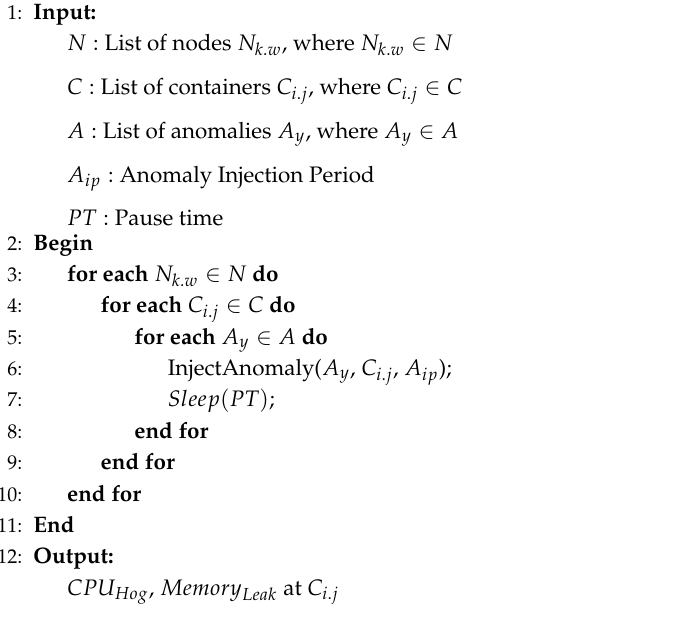
Algorithm 3 Anomaly Injection Algorithm at Container Level